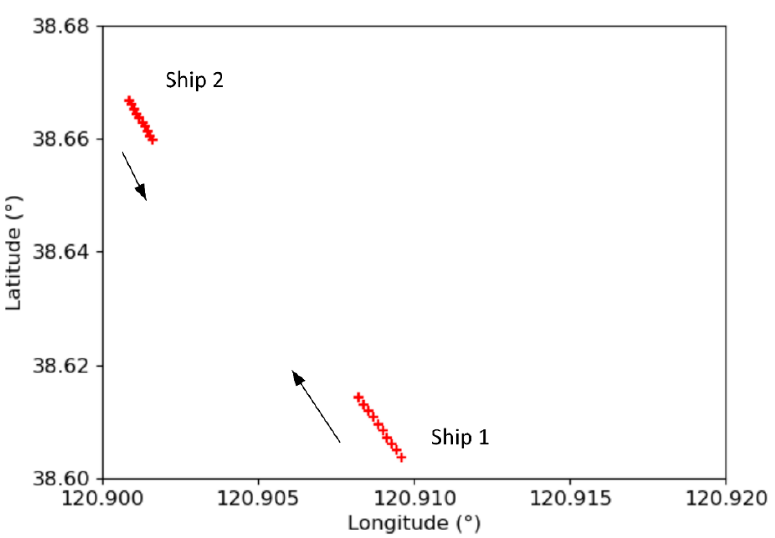
Figure 7. The trajectories of the two encountering ships in a head-on scenario.